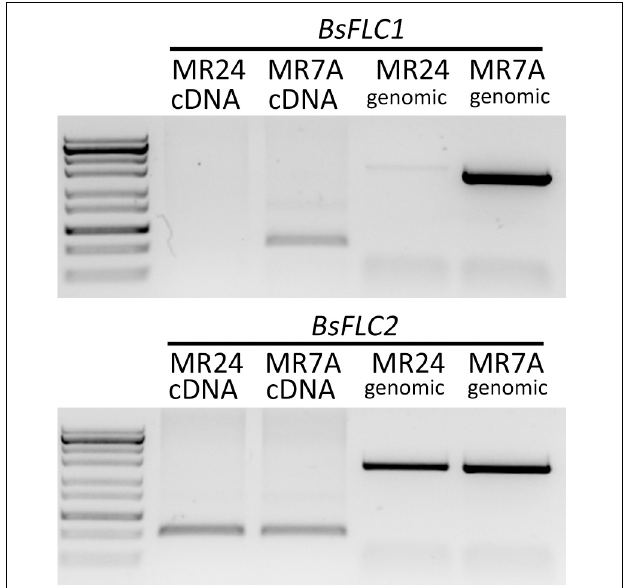
FIGURE 2 | Candidate gene profiling of two FLC copies. Labels for each gene ( BsFLC1 or BsFLC2 ), accession (MR24 or MR7A), and PCR template (cDNA or genomic) are above each lane. RNA was extracted from leaves in the rosette stage grown in 16-h day greenhouse condition. Ladder band from top to bottom (kb): 10, 5, 3, 2, 1.2, 0.85, 0.5, 0.3,